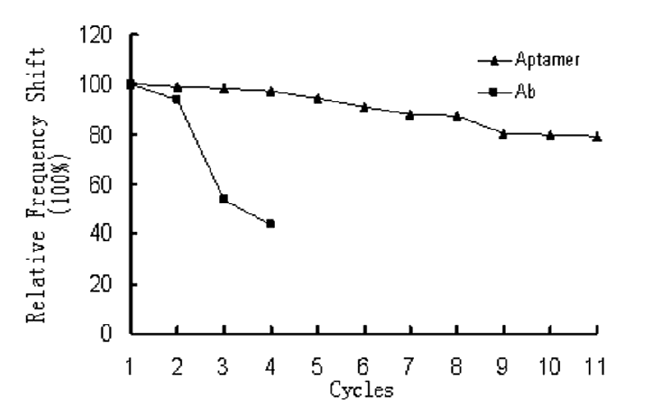
Figure 3. Comparison of the regeneration between aptamer-based biosensor and antibody-based biosensor by EDTA. IgE (100 μg/L) was applied to the gold surface for detection. The regeneration reagent was 30 mmol/L EDTA solution. The relative frequency shift (%) was the frequency shift measured relative to the response for the first measurement. The cycles of x-axis mean the number of the regeneration